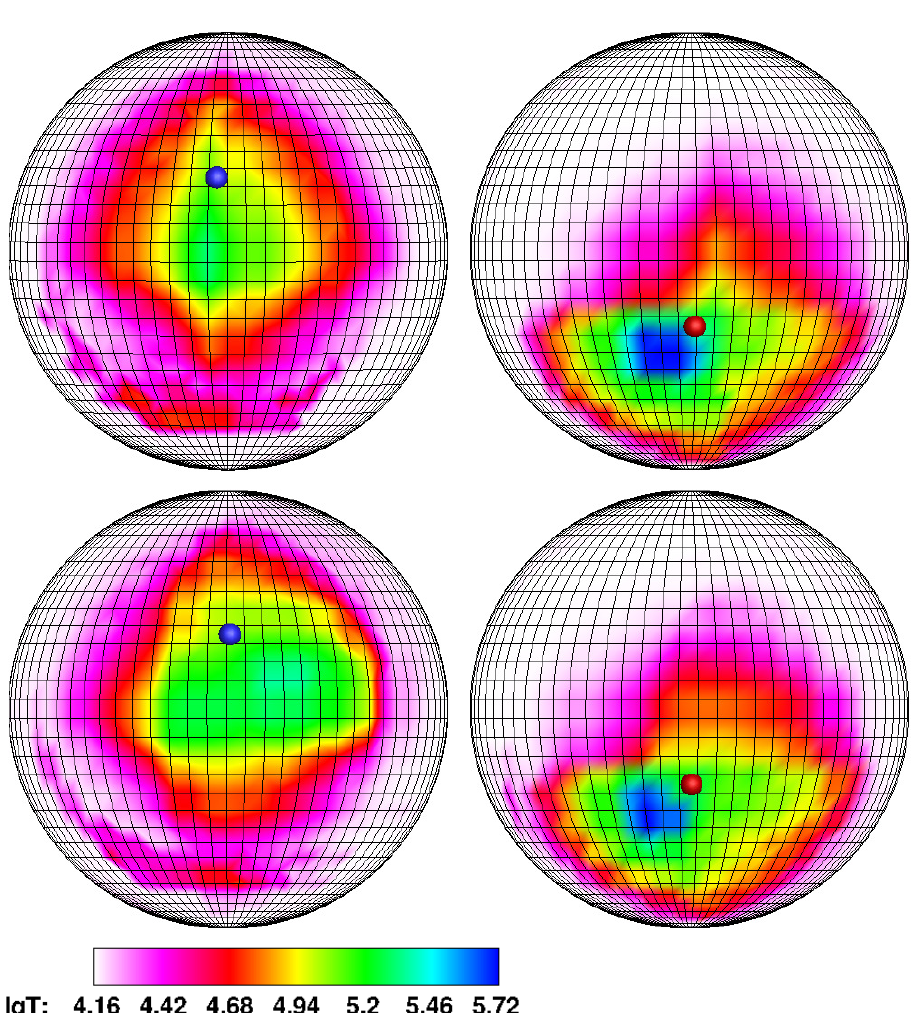
Figure 18. Temperature distribution over the accretor surface for the asynchronous polar with an offset dipole when switching the flow from the south magnetic pole to the north one. The temperature maps for Phase 1 ( upper panel) and for Phase 2 ( lower panel) are